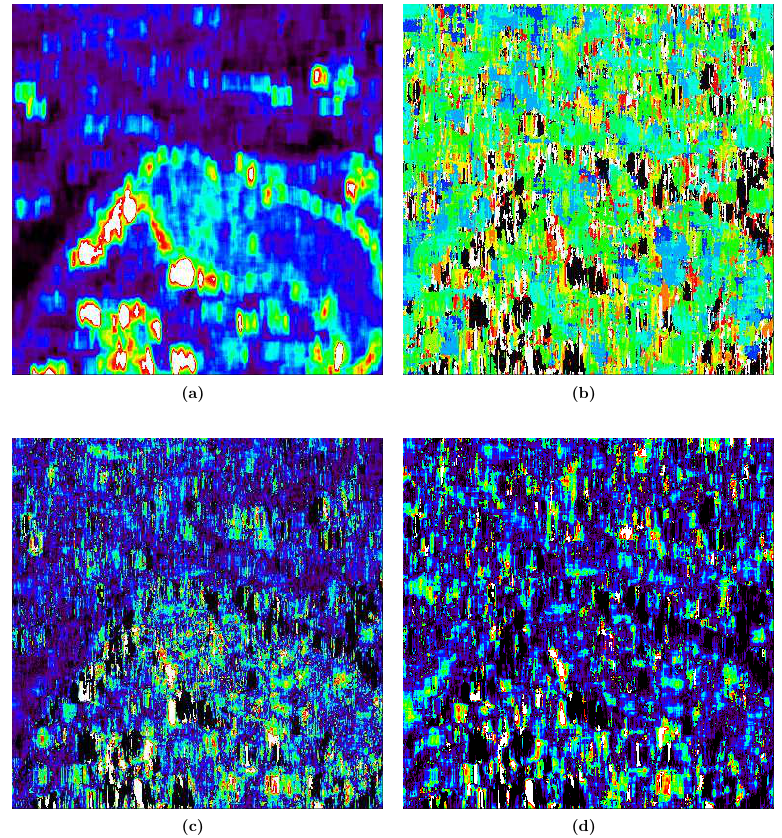
Figure 5. Vario-parameter maps resultant from classification of RADARSAT data set in Figure 3a. Based on first-order directional vario functions in 0 ◦ (east–west) direction calculated for windows of 20 by 20 pixels with offset 1 pixel. ( a ) pond; ( b ) mindist; ( c ) p1; ( d )